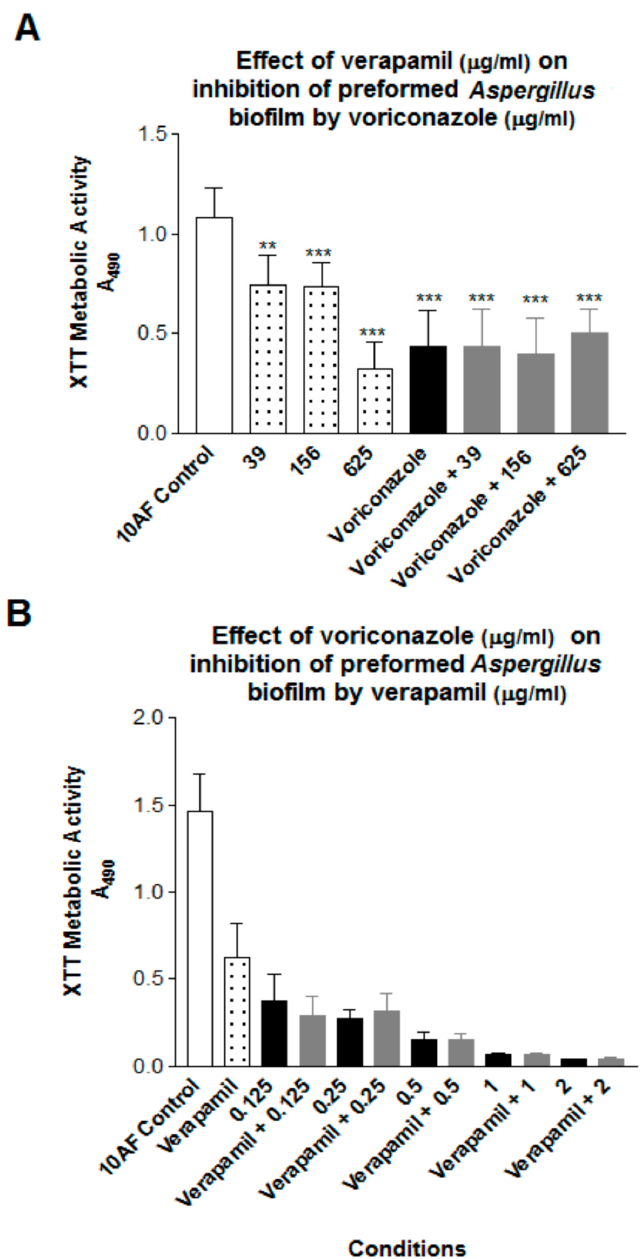
Figure 2. ( A ) Effect of verapamil doses on the effect of voriconazole on preformed Af biofilm. The voriconazole dose tested was 0.125 mcg/mL final concentration (4 right bars). The numbers 39, 156, 625 refer to verapamil final concentrations in mcg/mL. Two and three asterisks refer to p < 0.01 and 0.001, respectively, compared to no-drug control (left bar). The combination bars are not different from voriconazole alone; no potentiation of voriconazole by verapamil. ( B ) Effect of voriconazole doses on the effect of verapamil on preformed Af biofilm. The verapamil concentration tested, alone (second bar from left) or in combination, was 39 mcg/mL. The numbers 0.125 through 2 are final concentrations of voriconazole in mcg/mL, alone or in combination. The no-drug control is at the left, and is p < 0.001 different from all other bars. The voriconazole alone bars are plotted here side-by-side with the corresponding combination bars; there are no differences in any pair. Indifference is again demonstrated.